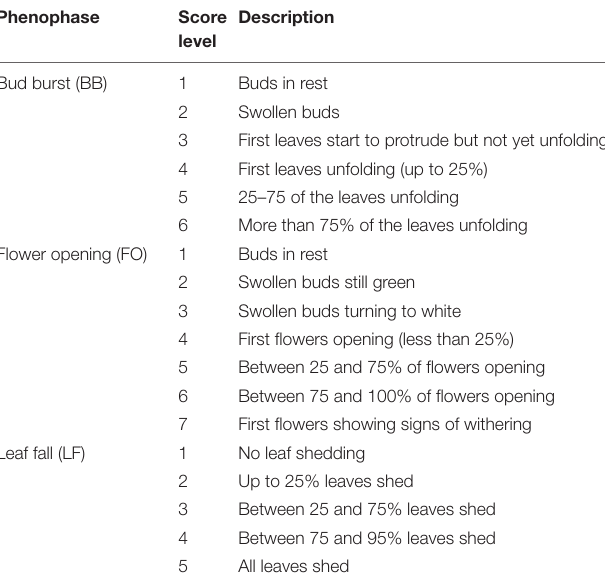
TABLE 2 | Description of morphological leaf and fruit traits. Trait